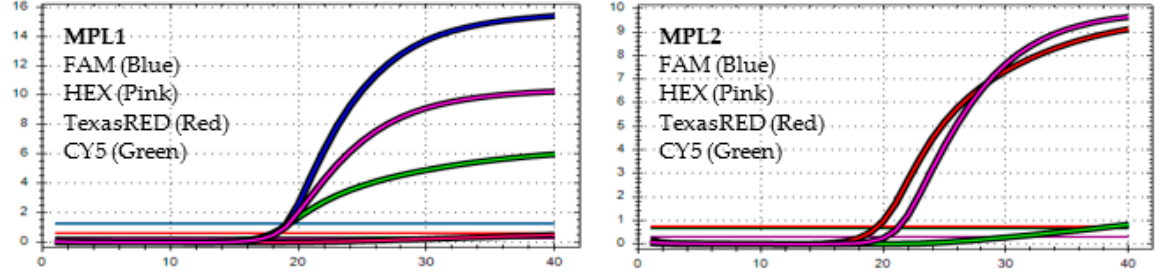
Table 3. The mutations detected in each pa tt ern by Sanger sequencing and compared with the deletion mutations detected by the MPL RT-rPCR. Figure 6. In MPL1 : No target failure is detected. In MPL2 , the target failure is detected in channel FAM. No ampli fi cation is detected in channel CY5 because of the competition of high viral load with the IC (human RNAse P). This pa tt ern is identi fi ed as variant Delta . the MPL RT-rPCR